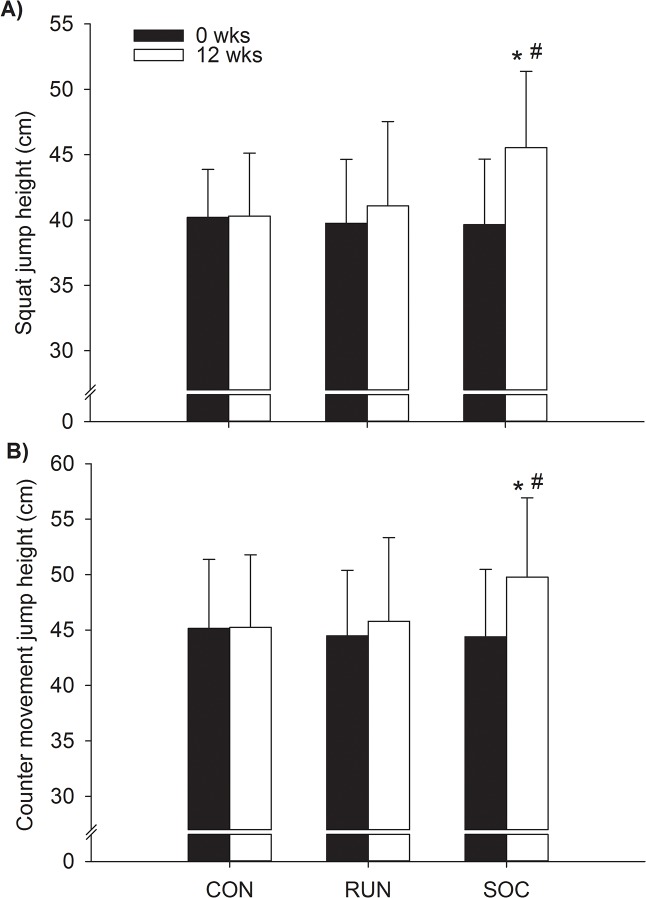
Differences among soccer (SOC), running (RUN) and control (CON) groups in: A) squat jump performance and B) countermovement jump with arm swing; *—denotes significant difference compared to baseline (p<0.05); #—significant difference between SOC and RUN group in post intervention (p<0.05).